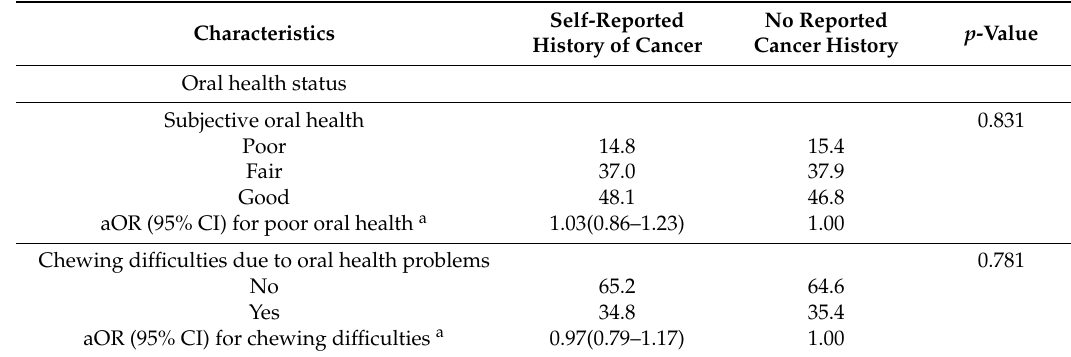
Table 2. Oral health status and behavior among cancer survivors compared to controls without a cancer